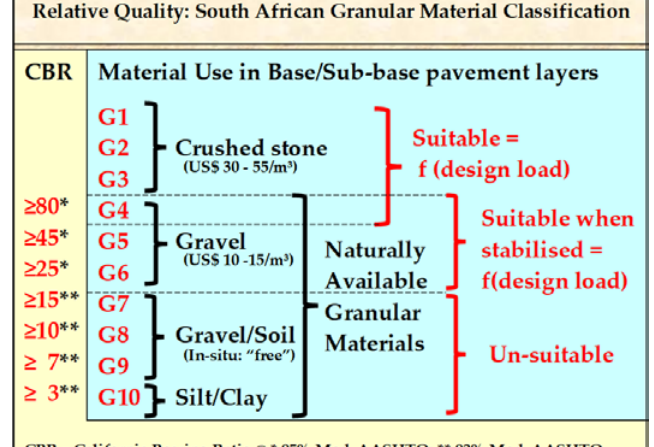
Figure 1. Summary of the comparative relative qualities of granular materials as defined using the South African road building material classification system [21–23] (for definition of Mod AASHTO, refer to [24,25]). Typical material costs shown are based on South African experience (2021, excluding haulage costs) and these costs may vary considerably.